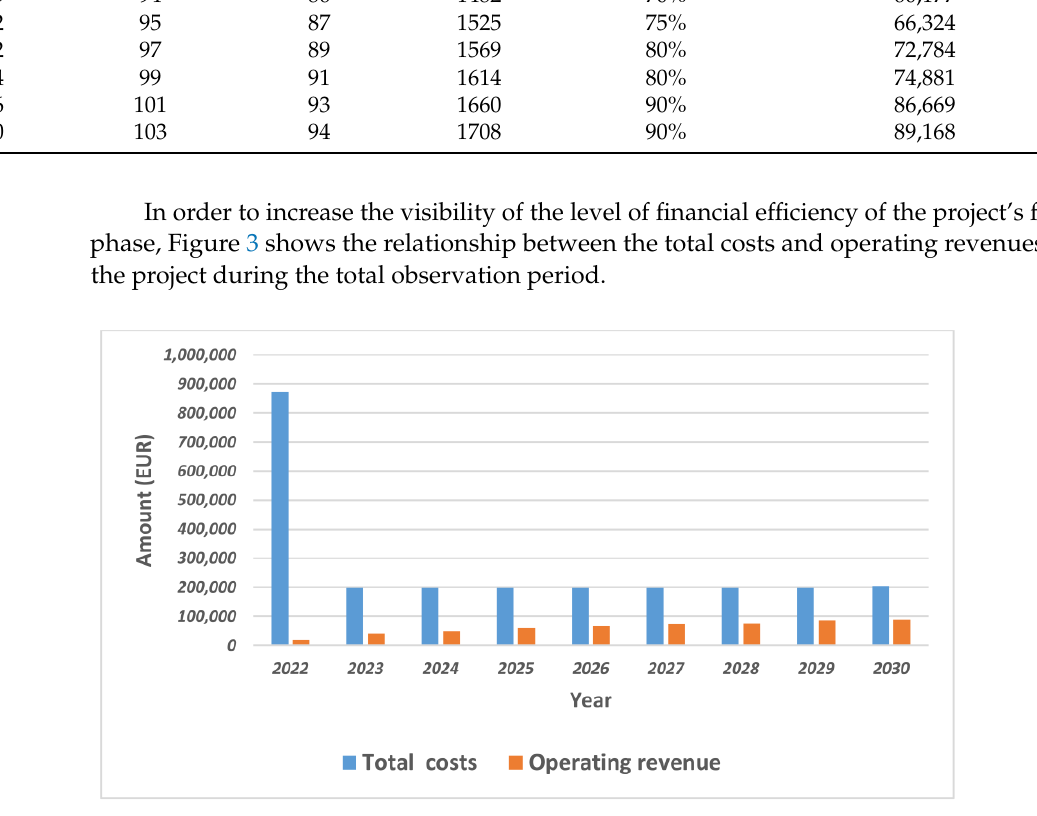
Figure 3. Total costs and operating revenue of the project.